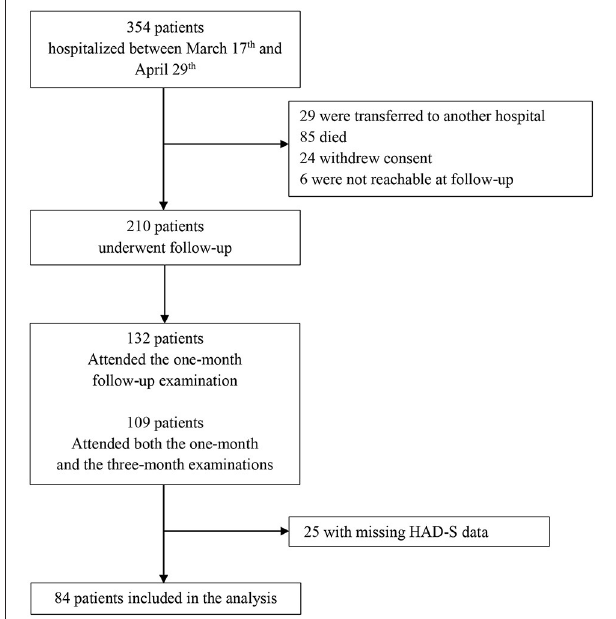
FIGURE 1 | Flow of patients in the study. Between March 17th and April 29th, 2020, 354 patients hospitalized at HEGP were included in the French COVID cohort. Among these patients, 29 were lost at follow-up because of inter-hospital transfer, 85 died, 24 withdrew their consent, and 6 were not reachable. Among the 210 remaining patients who underwent the follow-up, 132 attended the 1-day follow-up examination at 1 month, including 109 who also attended the 1-day follow-up examination at 3 months. Among these 109 patients, 84 had HAD-S data at 1-month